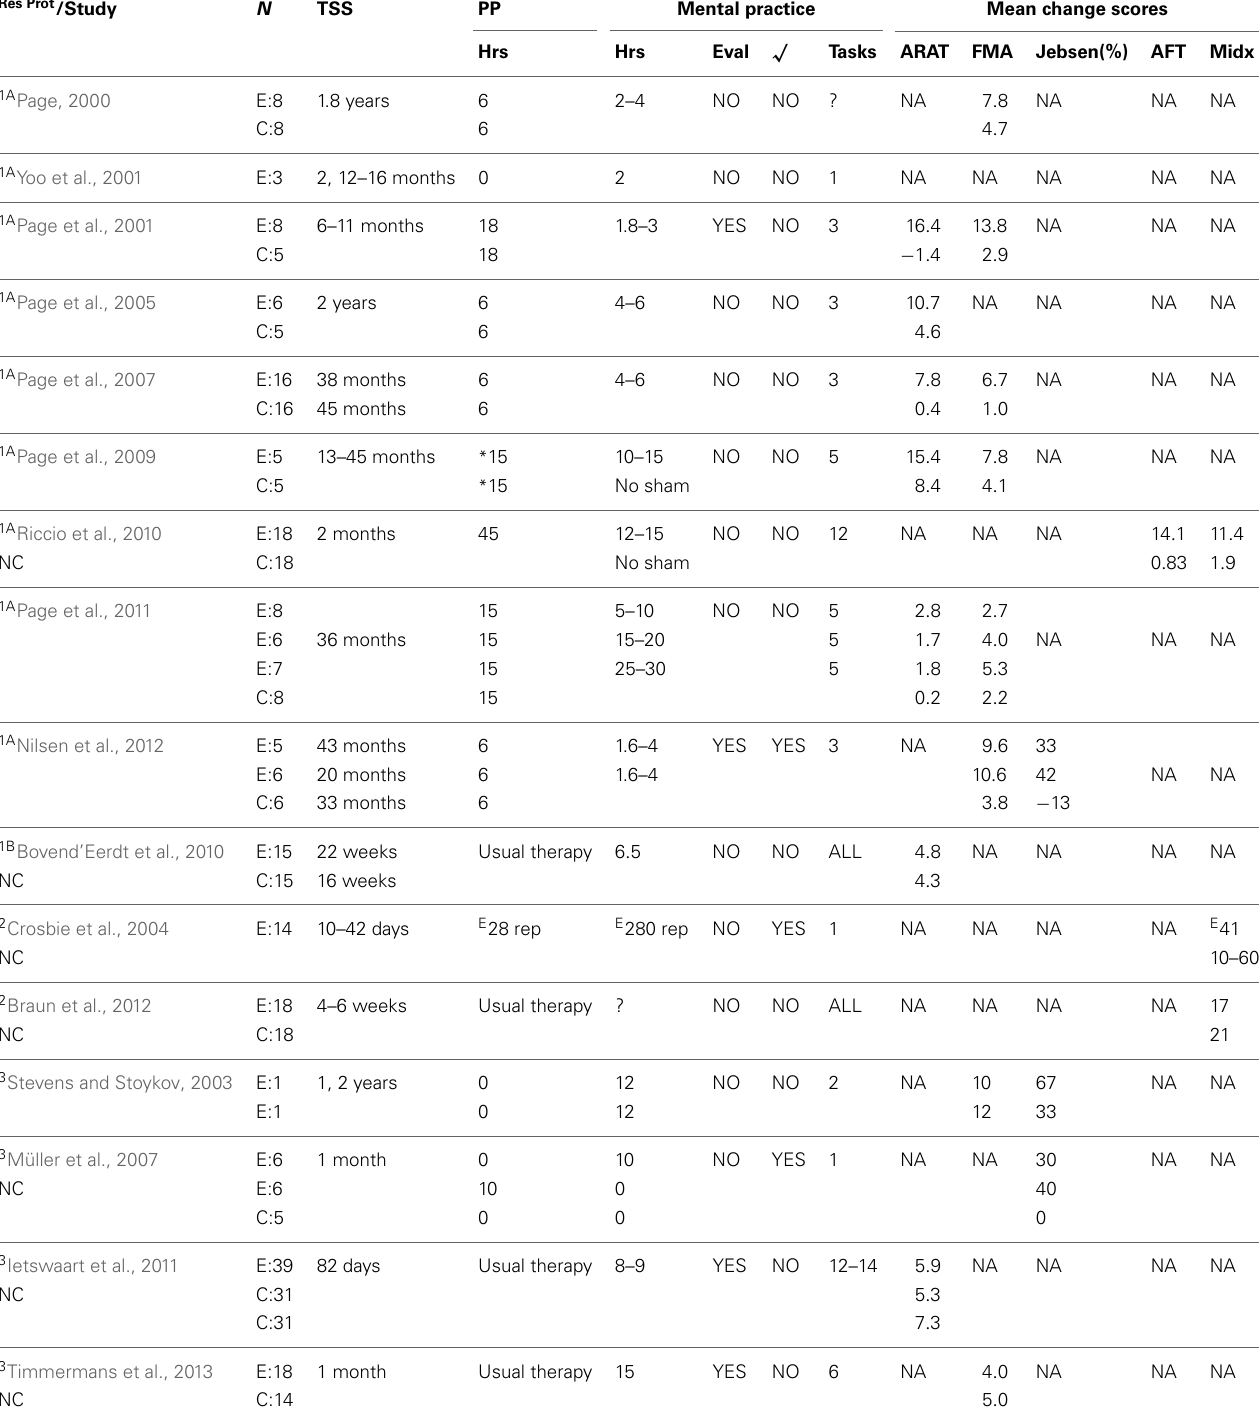
Table 3 | Characteristics of MI training studies for upper limb tasks. Res Prot /Study N TSS PP Mental